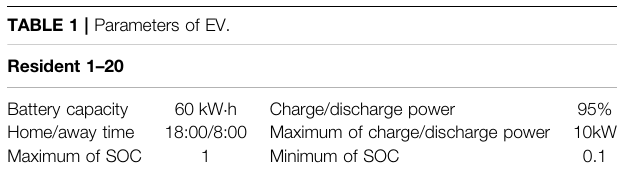
TABLE 1 | Parameters of EV.